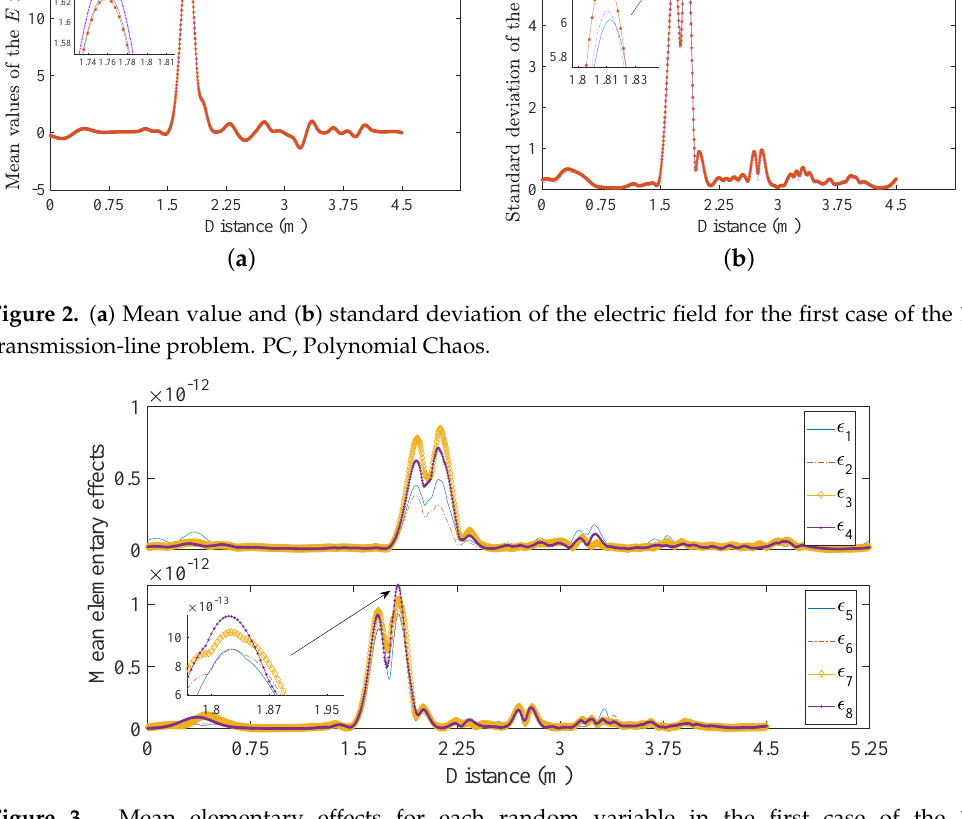
Figure 3. Mean elementary effects for each random variable in the first case of the 1D transmission-line problem.